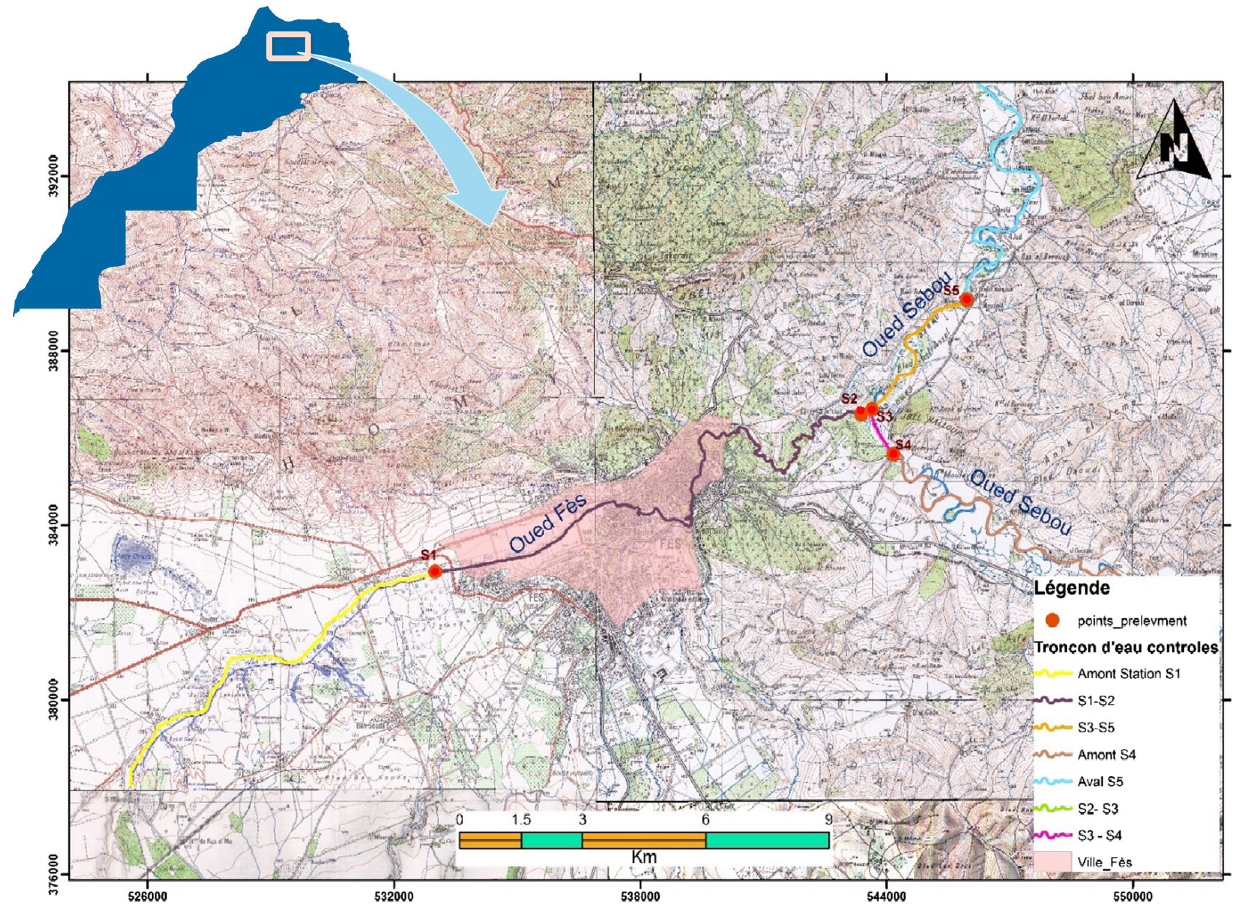
Fig. 1 Chart of localization of the various